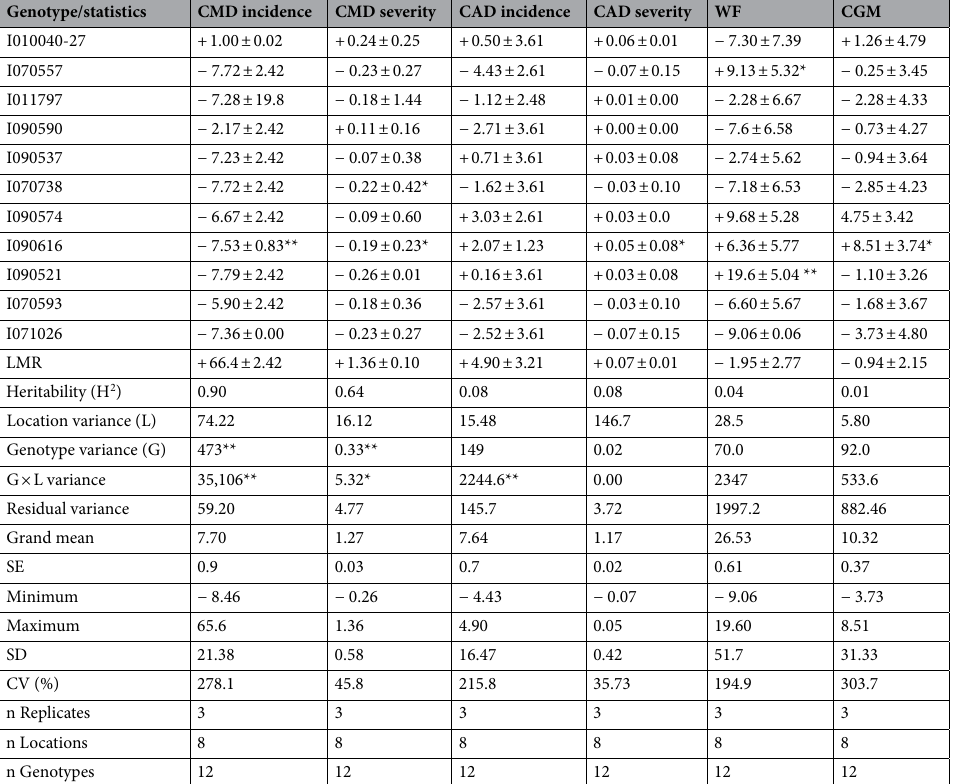
Table 2. Best linear unbiased predictors (BLUPs) of breeding values with standard errors for cassava mosaic disease (CMD) incidence (%) and severity, cassava anthracnose disease (CAD) incidence (%), and densities of, whiteflies (WF), cassava green mite (CGM). * P < 0.05, ** P < 0.01. The statistics listed for every trait are broad- sense heritability, genotype variance, residual variance, grand mean, SD = Standard Deviation, the coefficient of variation (CV %), the number of replications (n Replicates), and the number of genotypes (n Genotypes). The statistics shown are the estimates